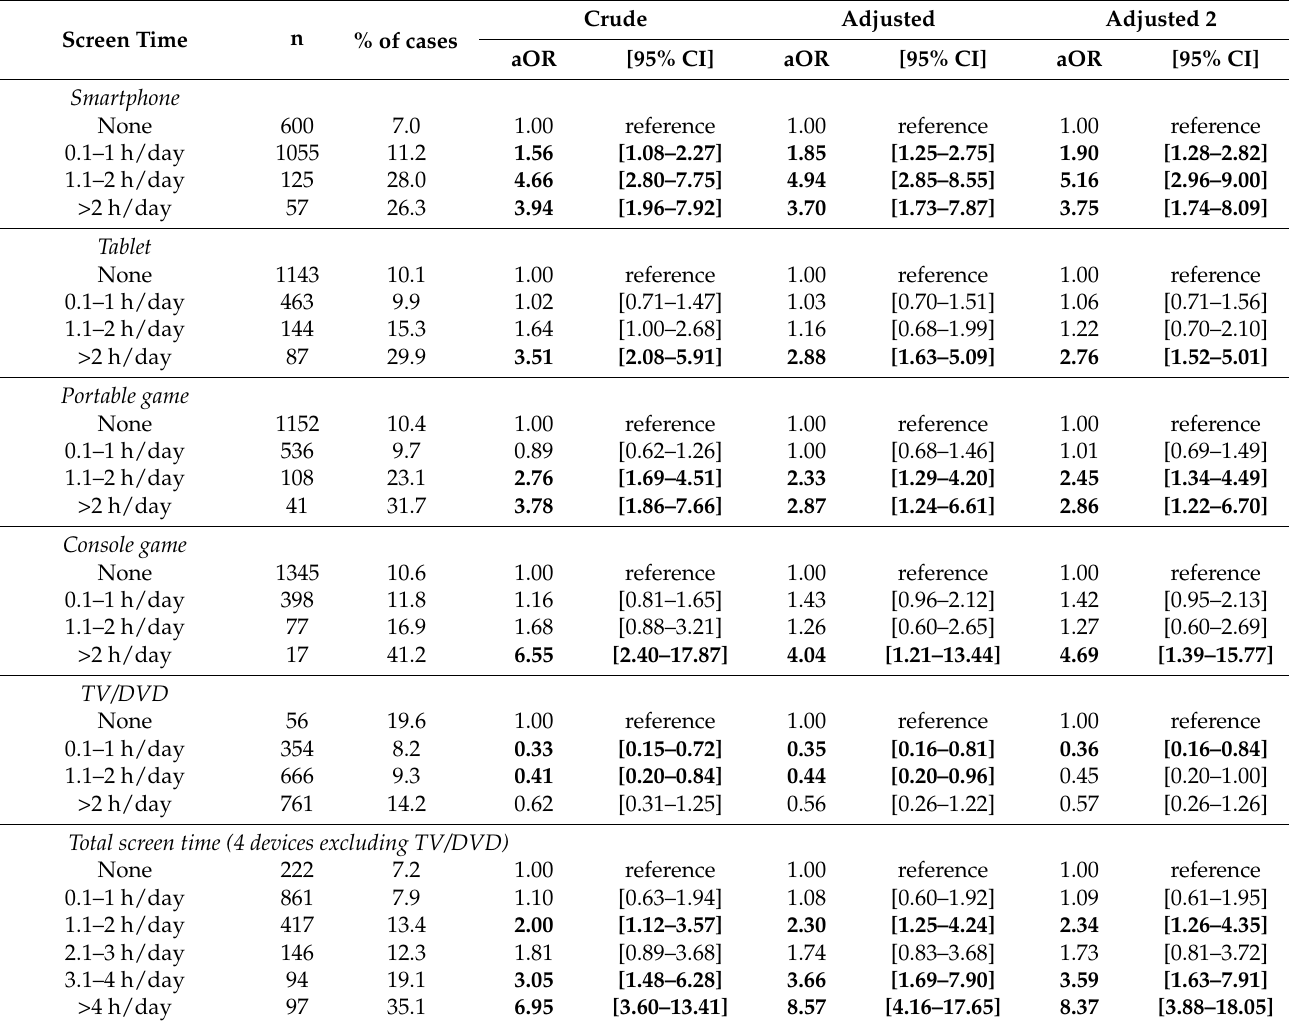
Table 3. Associations between children’s delayed bedtime (after 22:00 h) and screen time (N =